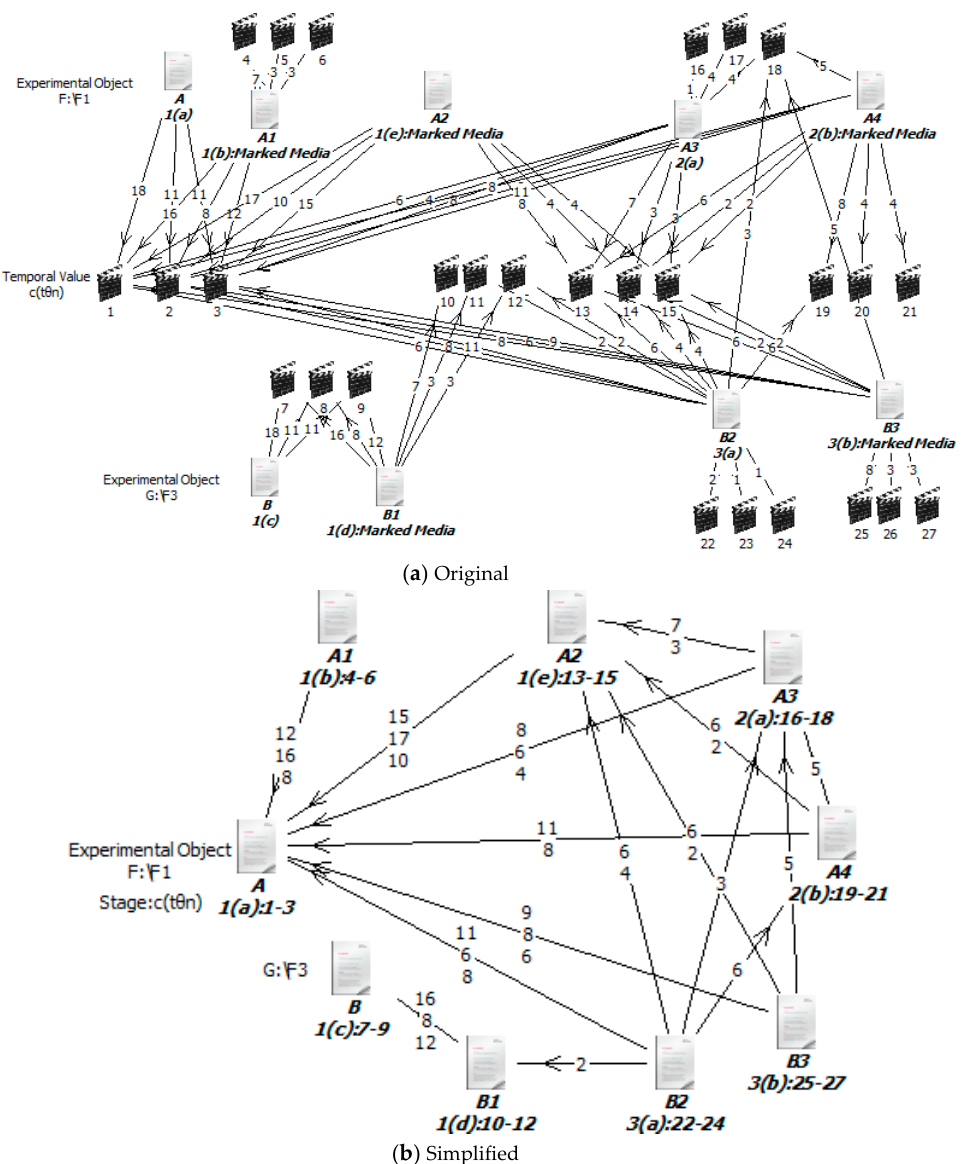
Figure 5. Relational reconstruction from temporal values and varieties (experiment).